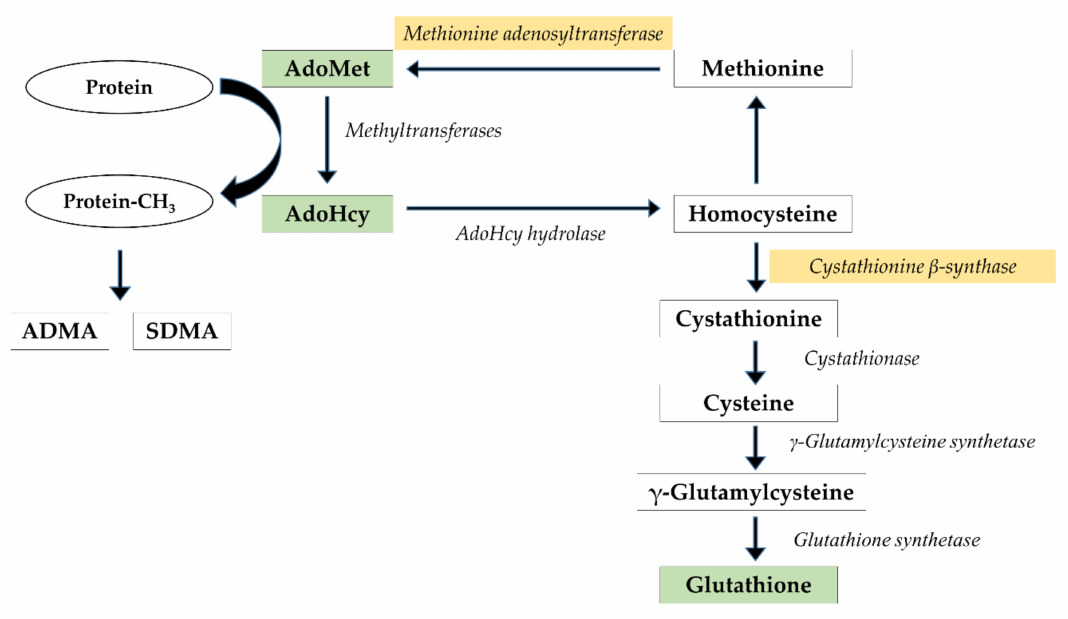
Figure 1. The methylation cycle and glutathione synthesis pathway. Metabolites and enzymes analyzed in the present study are shown in di ff erent